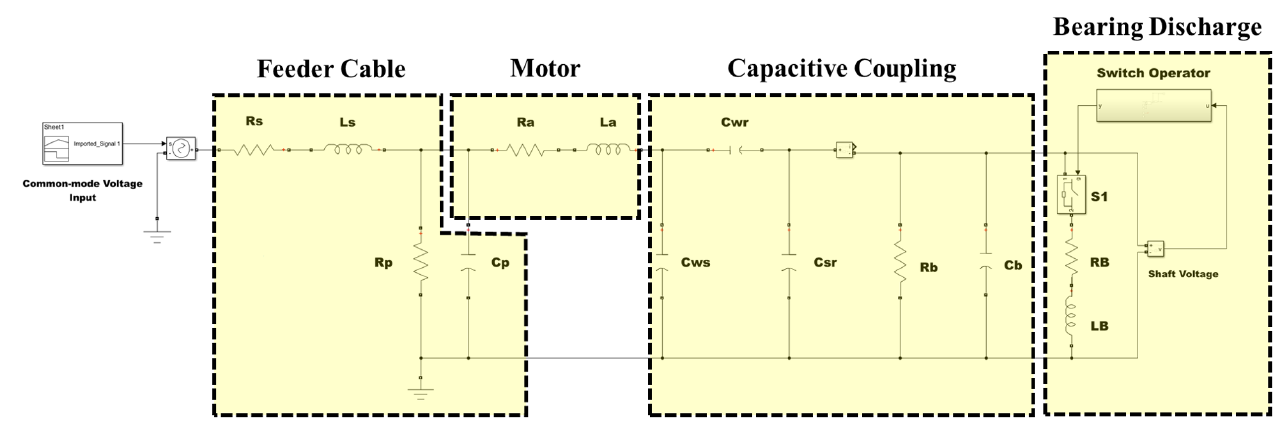
Figure 16. Simulation model for shaft voltage discharge in